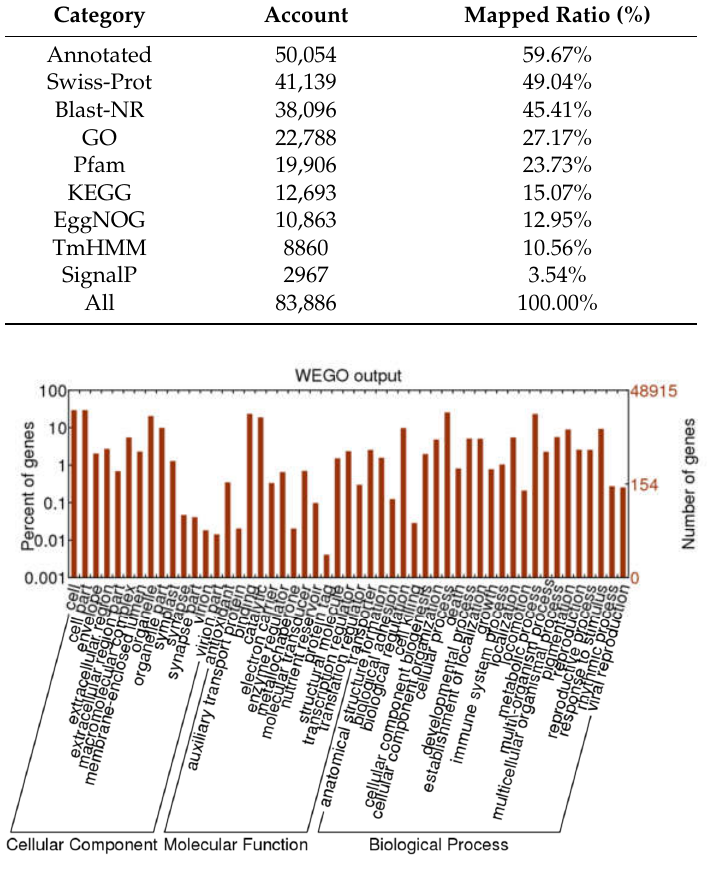
Figure 2. Gene ontology classification of A. megalophylla unigenes.